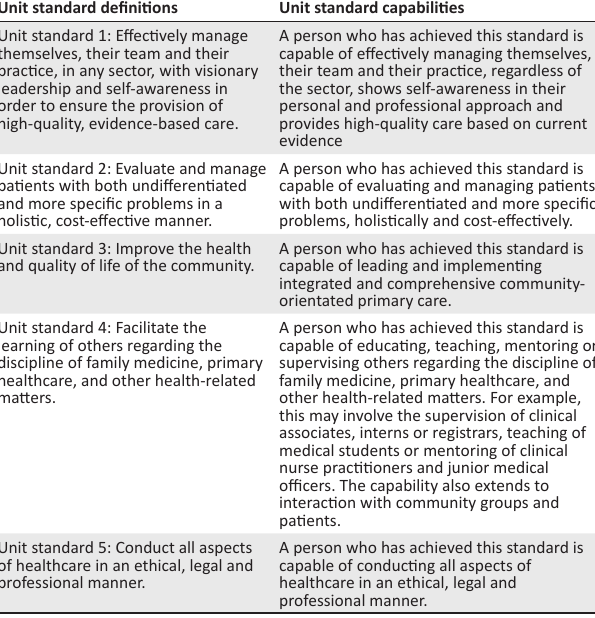
TABLE 1: Definitions of unit standards and capabilities required. Unit standard